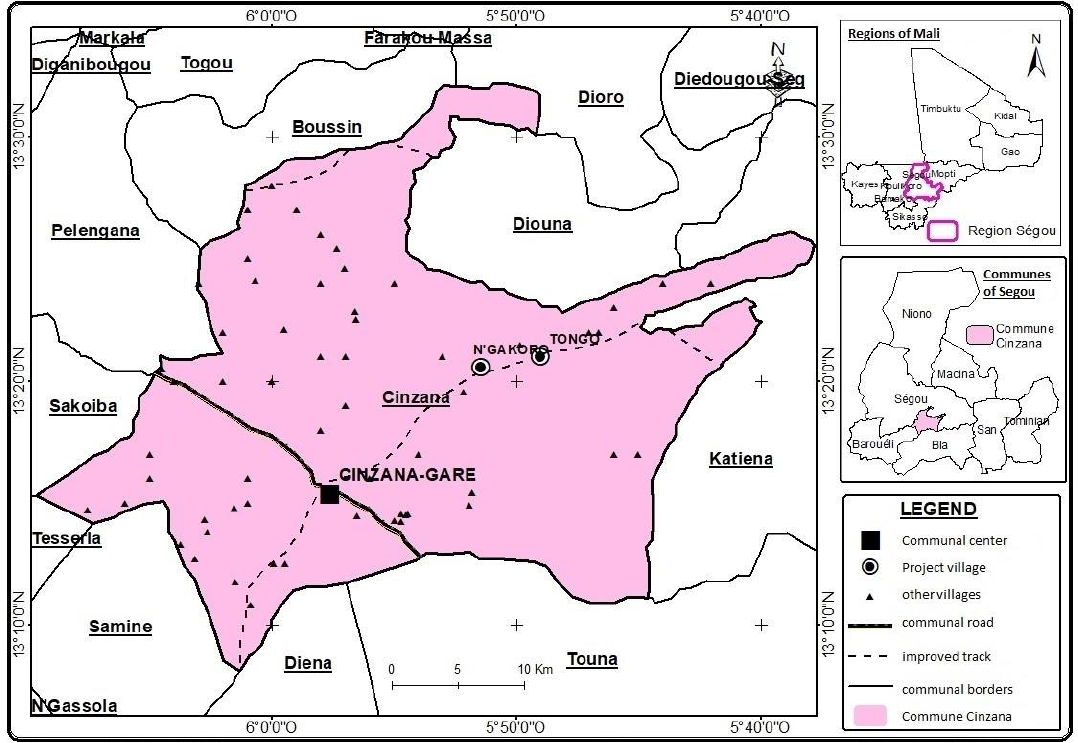
Figure 2. Climate-Smart village of Cinzana in S é gou Region in Mali, West Africa 13 ◦ 20 (cid:48) N 5 ◦ 51 (cid:48) W. Research villages N’Gakoro and Tongo